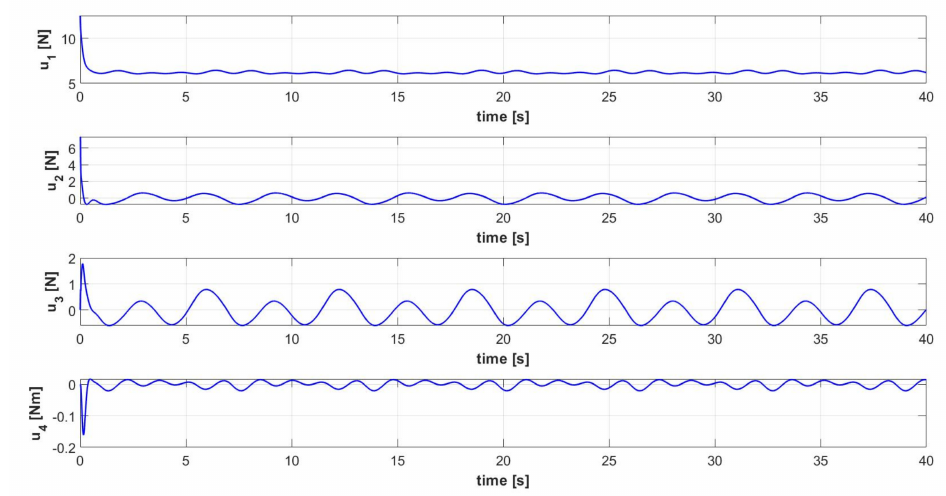
Figure 15. Control input signals [u 1 ( t ) , u 2 ( t ) , u 3 ( t ) , u 4 ( t ) ] of the controlled quadrotor system exe- cuting trajectory 2.